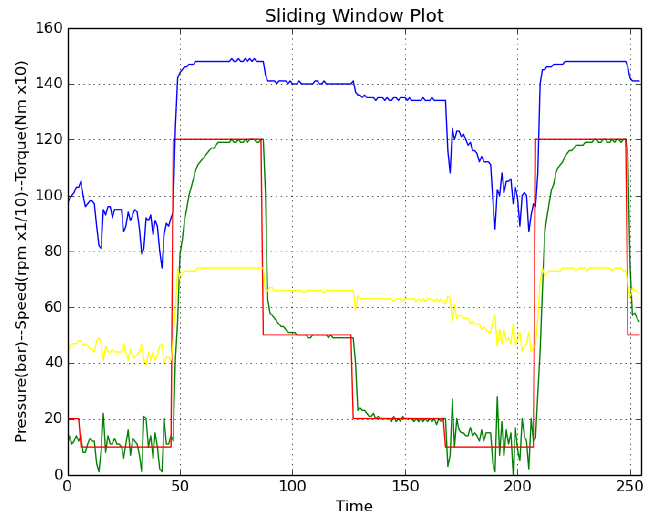
Figure 18. Speed step